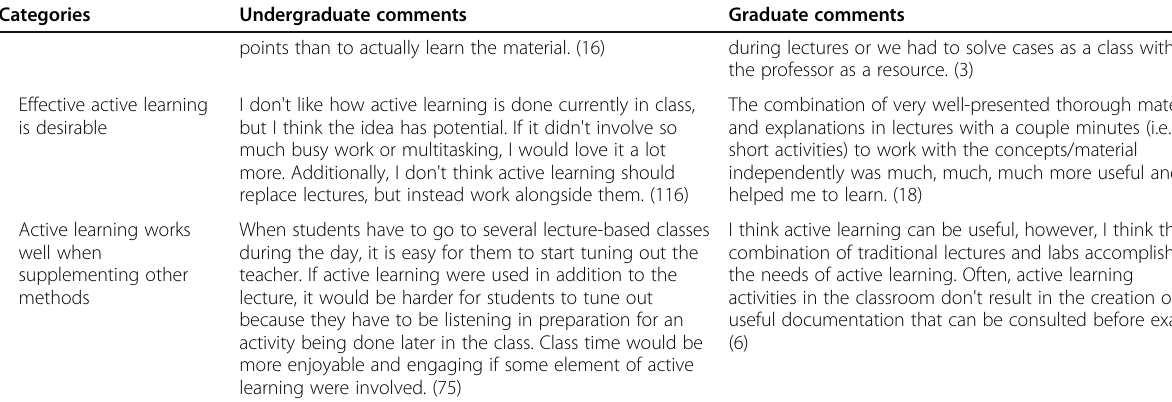
Table 4 Categories (Positive, Negative, and Constructive) and subcategories identified in student responses to the prompt “ Please describe your experiences with active learning in the classroom. ” Number of responses in each subcategory are included in parentheses after a sample comment (Continued)